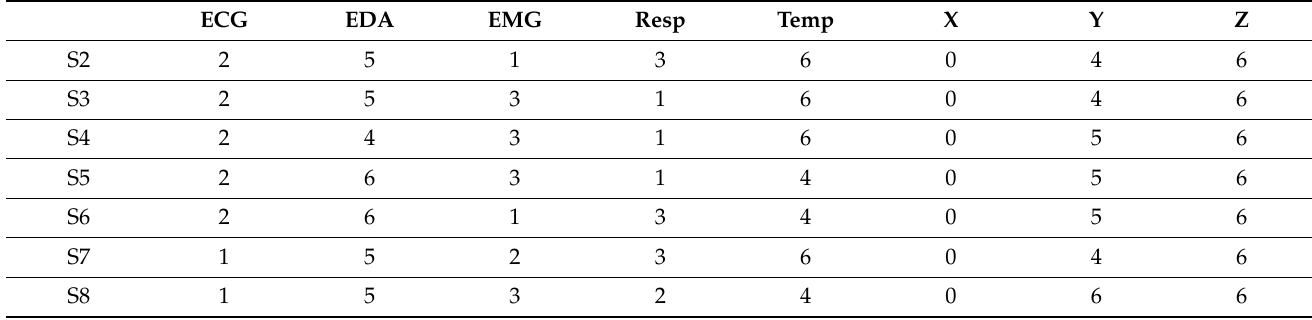
Table 1. Significance of the